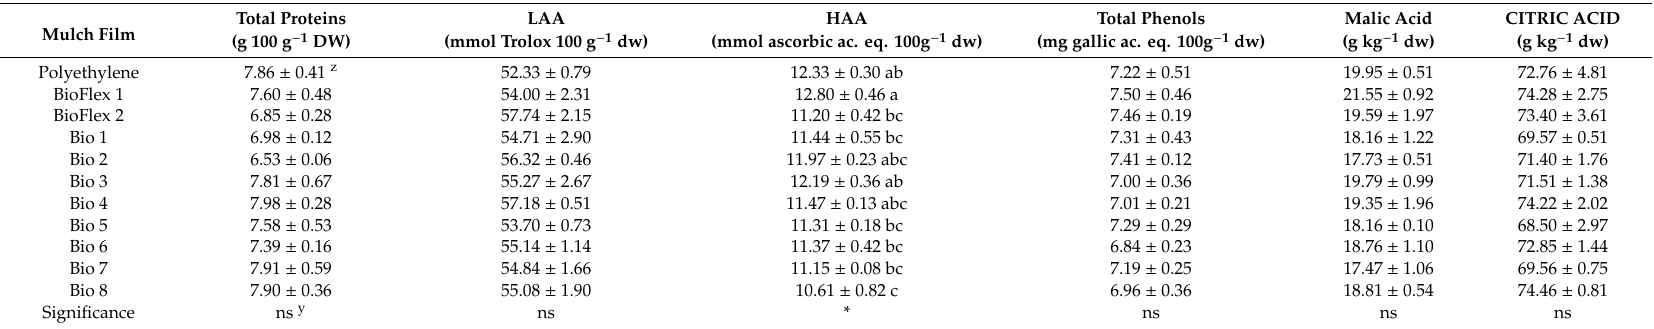
Table 4. E ff ects of di ff erent mulch films on total protein, antioxidant activities, total phenols, and malic and citric acids of greenhouse strawberry. Mulch